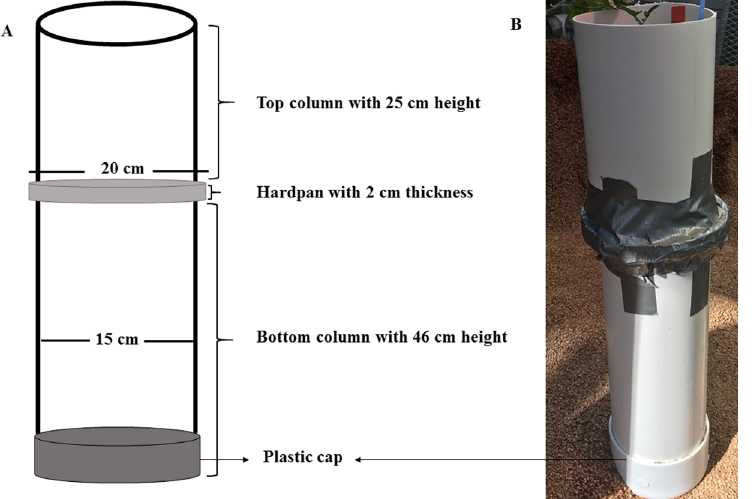
Fig 1. The mesocosm used to grow soybean plants in the experiment. Diagram of a mesocosm that was constructed of two stacked polyvinyl chloride (PVC) columns with an inside diameter of 15 cm (A). The height of the bottom and top columns were 46 and 25 cm, respectively. Each mesocosm was sealed at the bottom with a plastic cap, which had a central hole of 0.5 cm diameter for drainage. The synthetic hardpan made up of paraffin wax and petroleum jelly placed in between the top and bottom columns had a diameter of 20 cm and thickness of 2 cm. A photograph of the mesocosm (B). The top and bottom columns along with the synthetic hardpan in between were tightly sealed together with a duct tape as shown in Fig